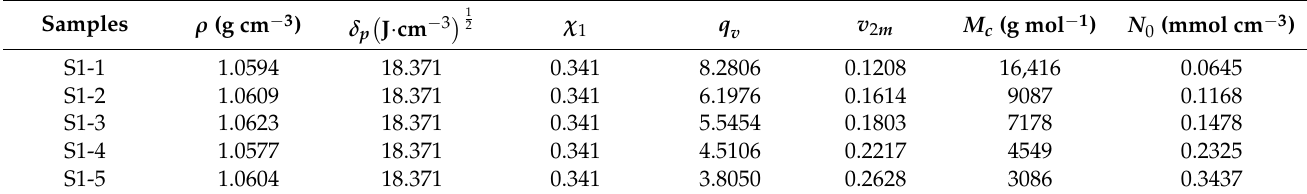
Table 3. Network structure parameters of elastomers with different R